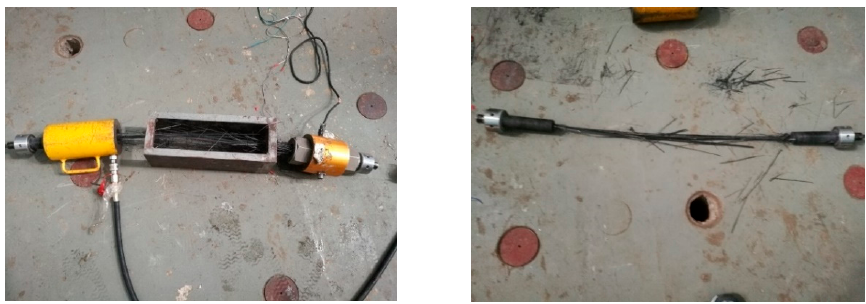
Figure 5. Failure mode of CFRP tendons. Table 1. Material properties.